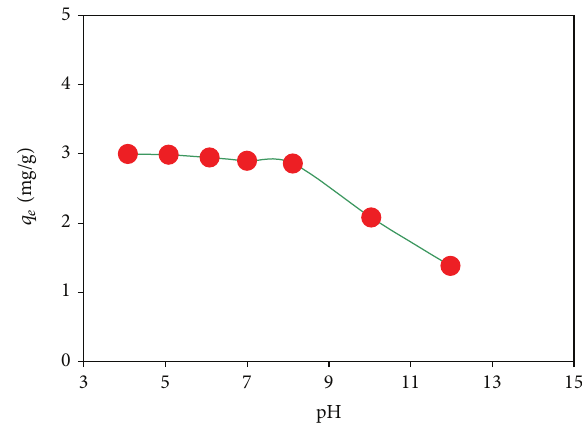
Figure2:EffectofcontacttimeonHg 2+ adsorptionofACCF.(Initial concentration 0.15 mg/L, ACCF dosage 0.0025 g/L, pH 4.08, and contact time 120min).